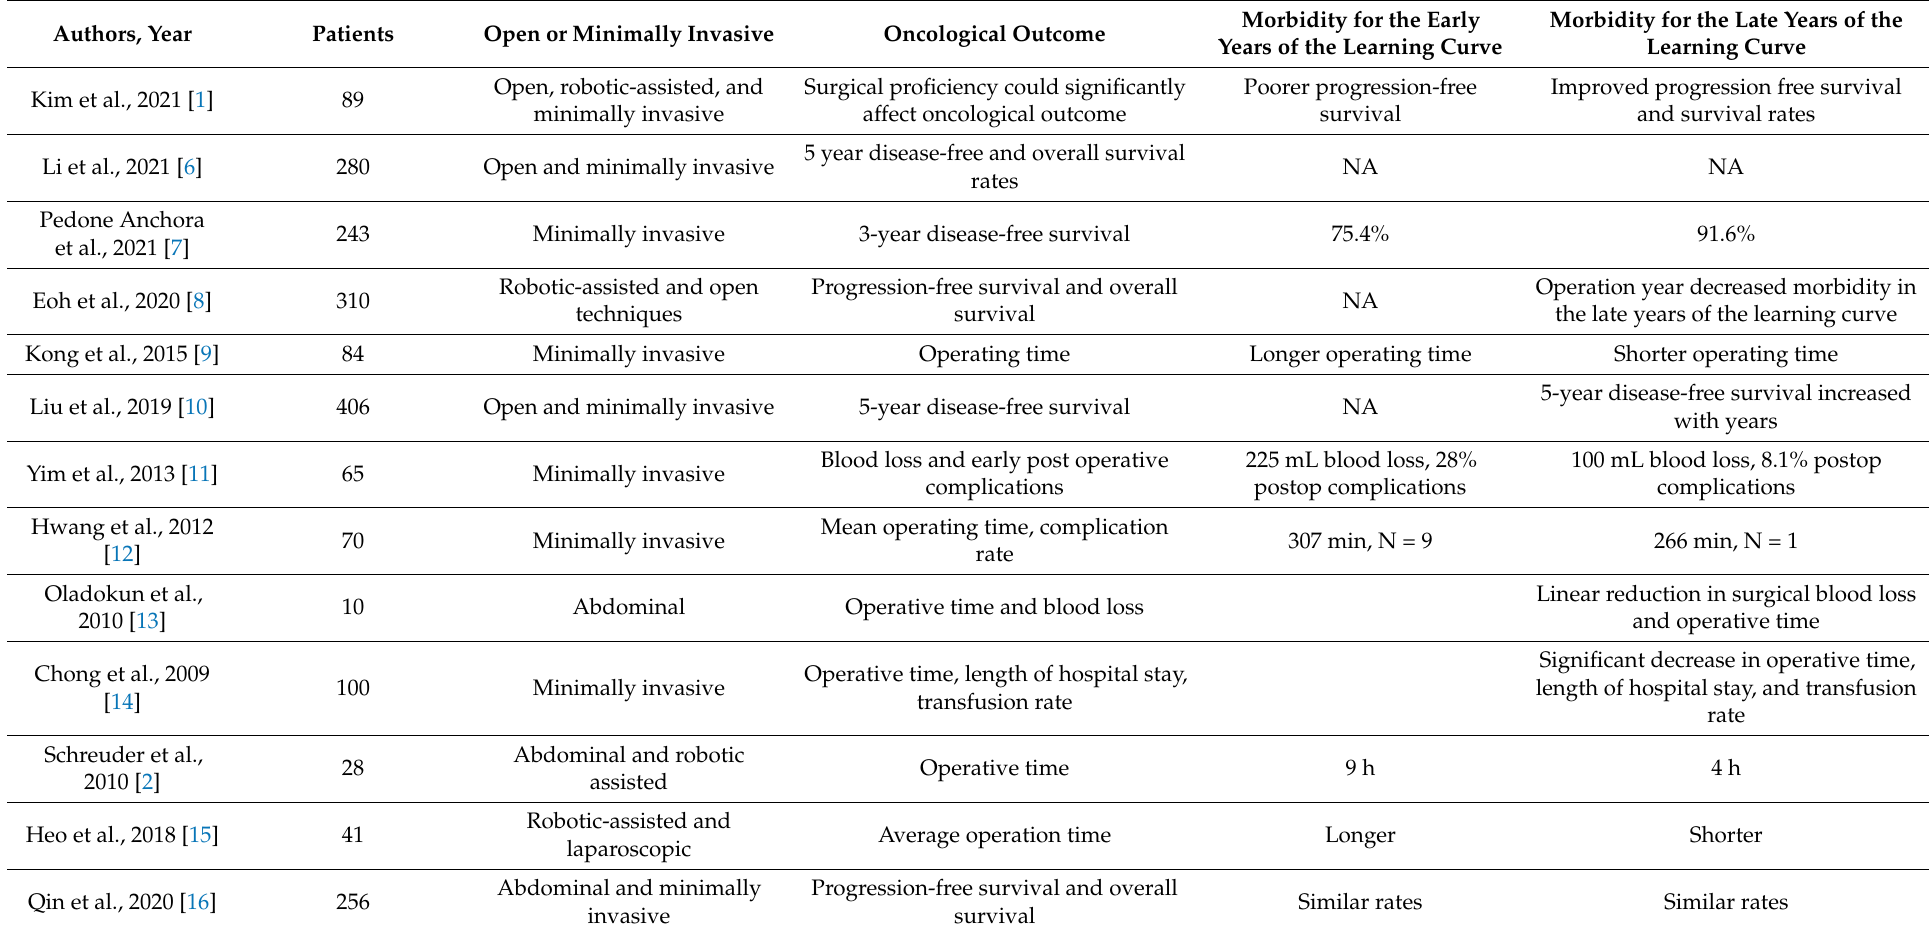
Table 1. Main characteristics and outcomes of the included